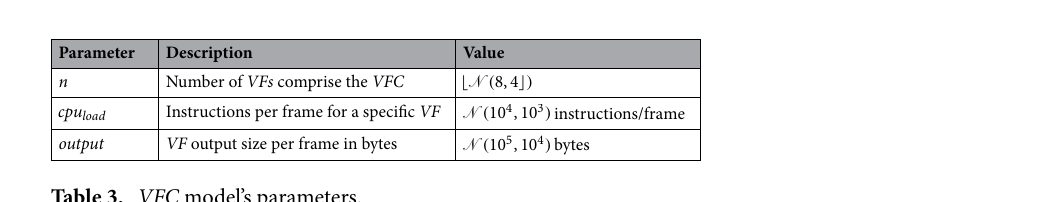
Table 3. VFC model’s